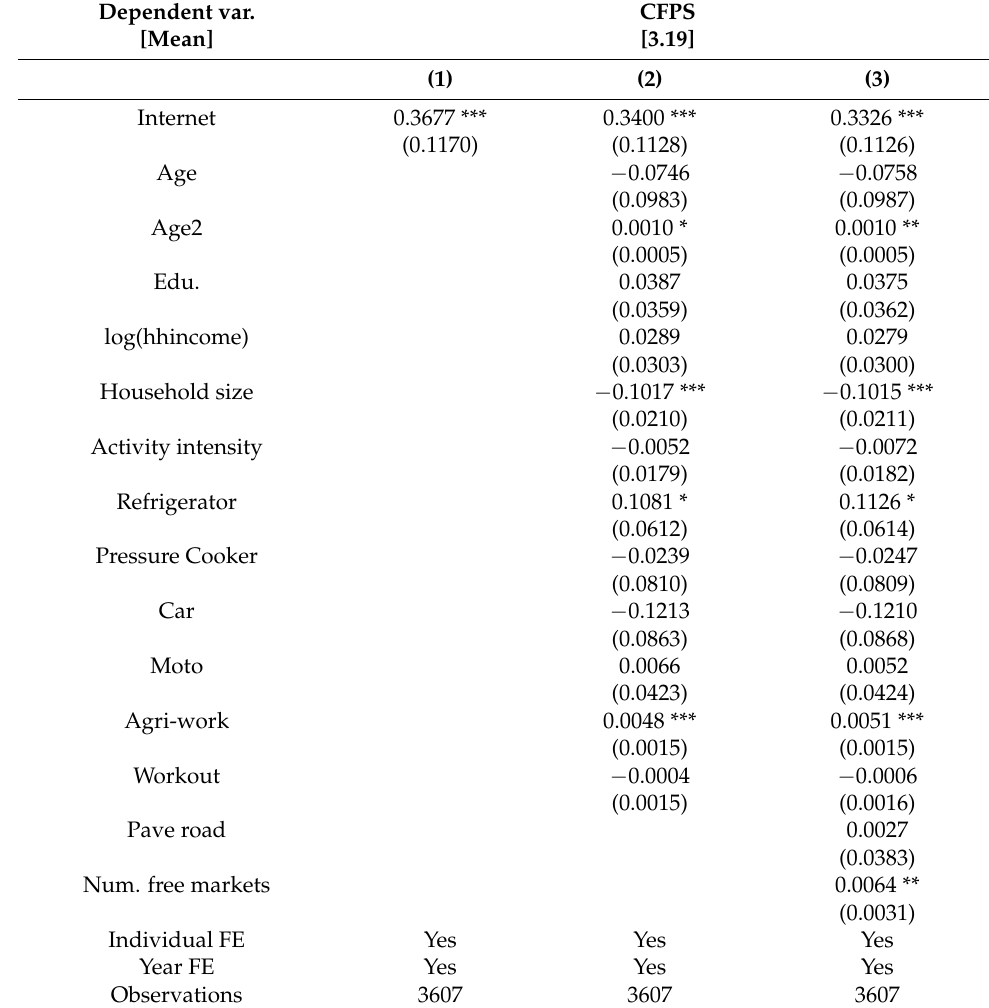
Table 2. Impact of Internet use on dietary quality of rural Chinese residents. Dependent